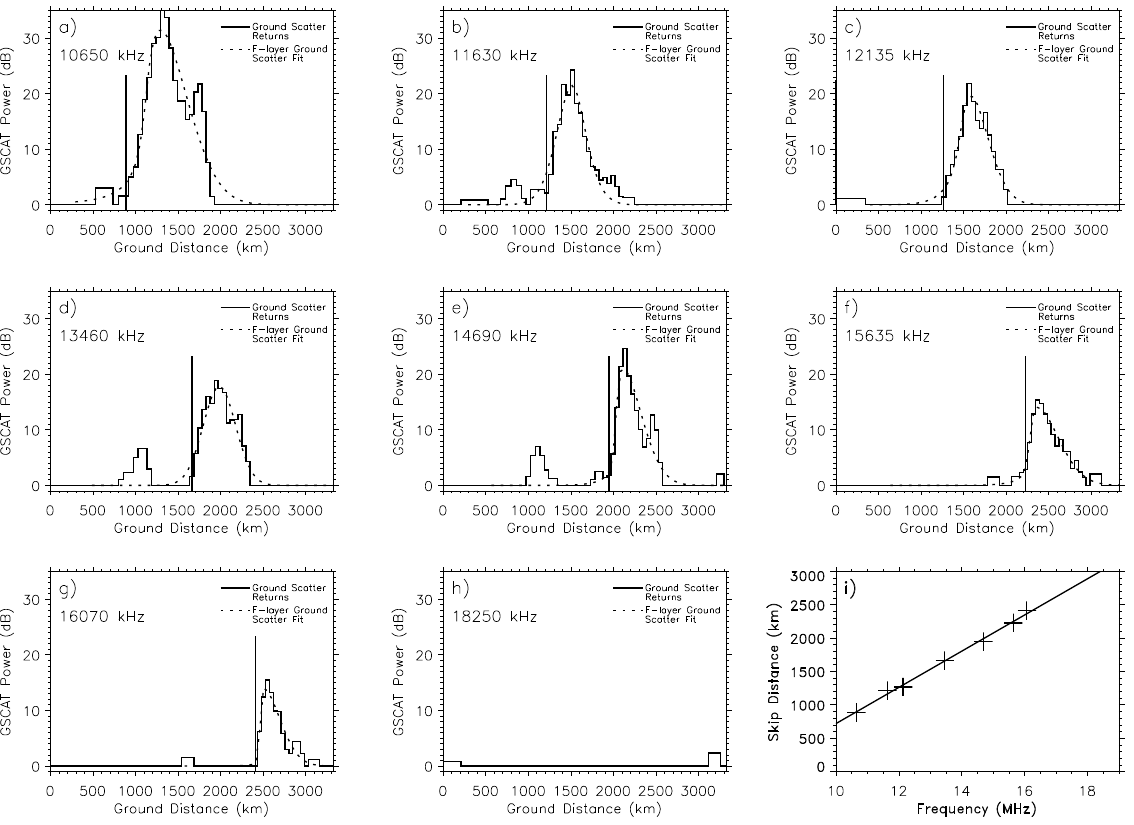
Fig. 1. (a)–(h) Ground-scatter as a function of range from the Kodiak SuperDARN radar observed on 23 June 2001 between 22:40 and 22:55UT. The solid vertical lines in each panel show the F-region skip distance. (i) F-region skip distances identified in (a)–(h) plotted as a function of frequency. The solid line is a linear least-squares fit to these